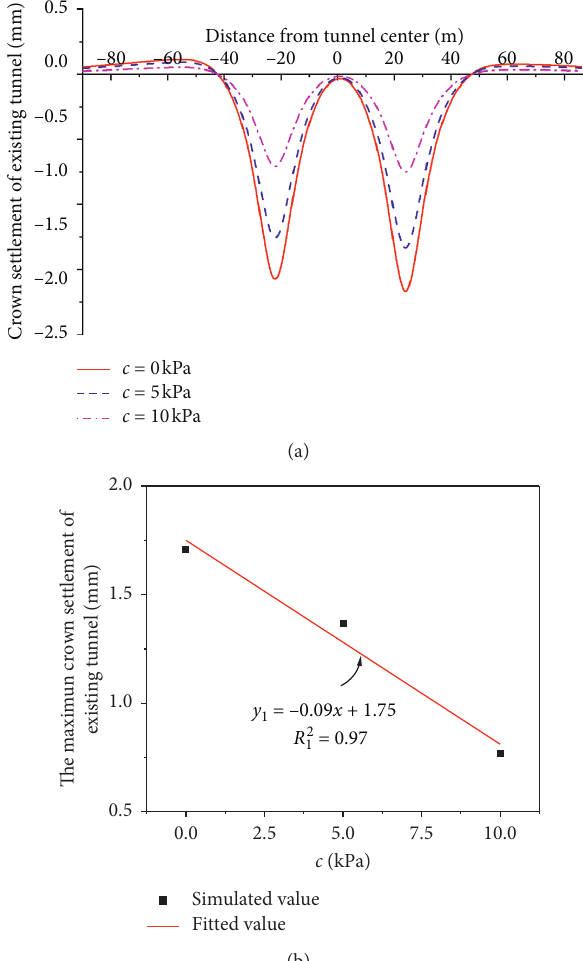
Figure 16: The influence of soil cohesion on the crown settlement of existingtunnel.(a)Thesettlementcurves oftheexistingtunnel. (b)The linear fitting of the maximum settlement value of the existing